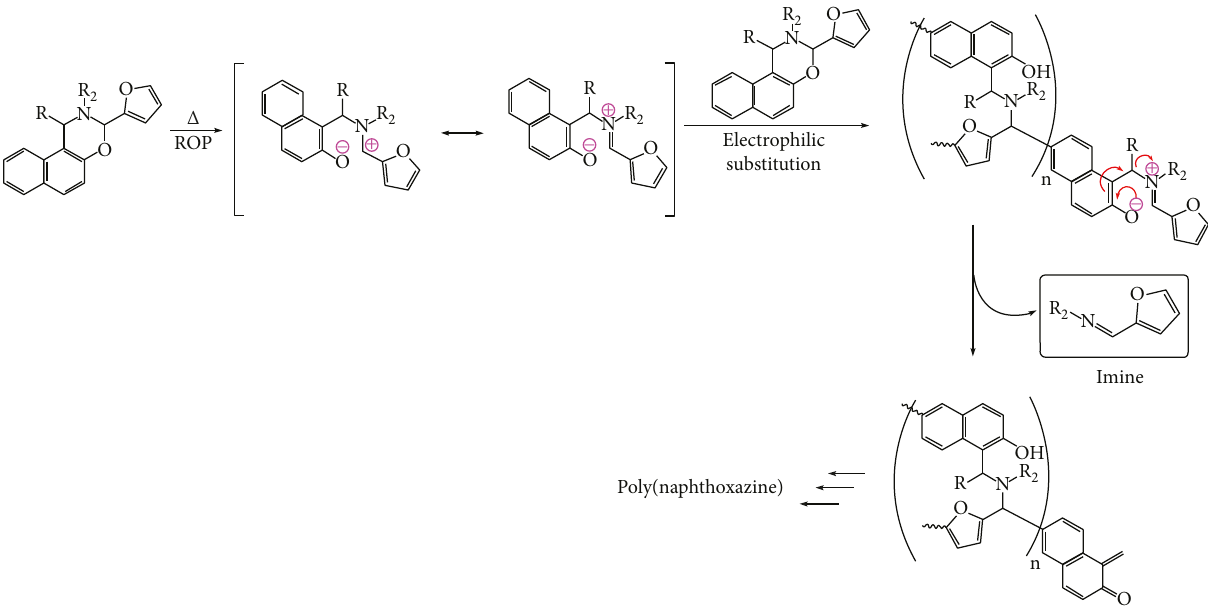
Figure 10: Proposed mechanism for the formation of an imine as a by-product of the polymerization process.